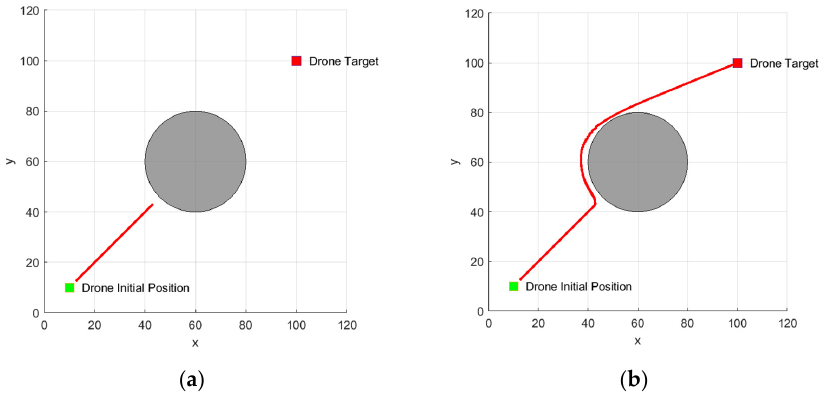
Figure 13. Escape local optimal solution using virtual ‐ target gravitational field. ( a ) Traditional arti ‐ ficial ‐ potential ‐ field method. ( b ) Improved artificial ‐ potential ‐ field method.